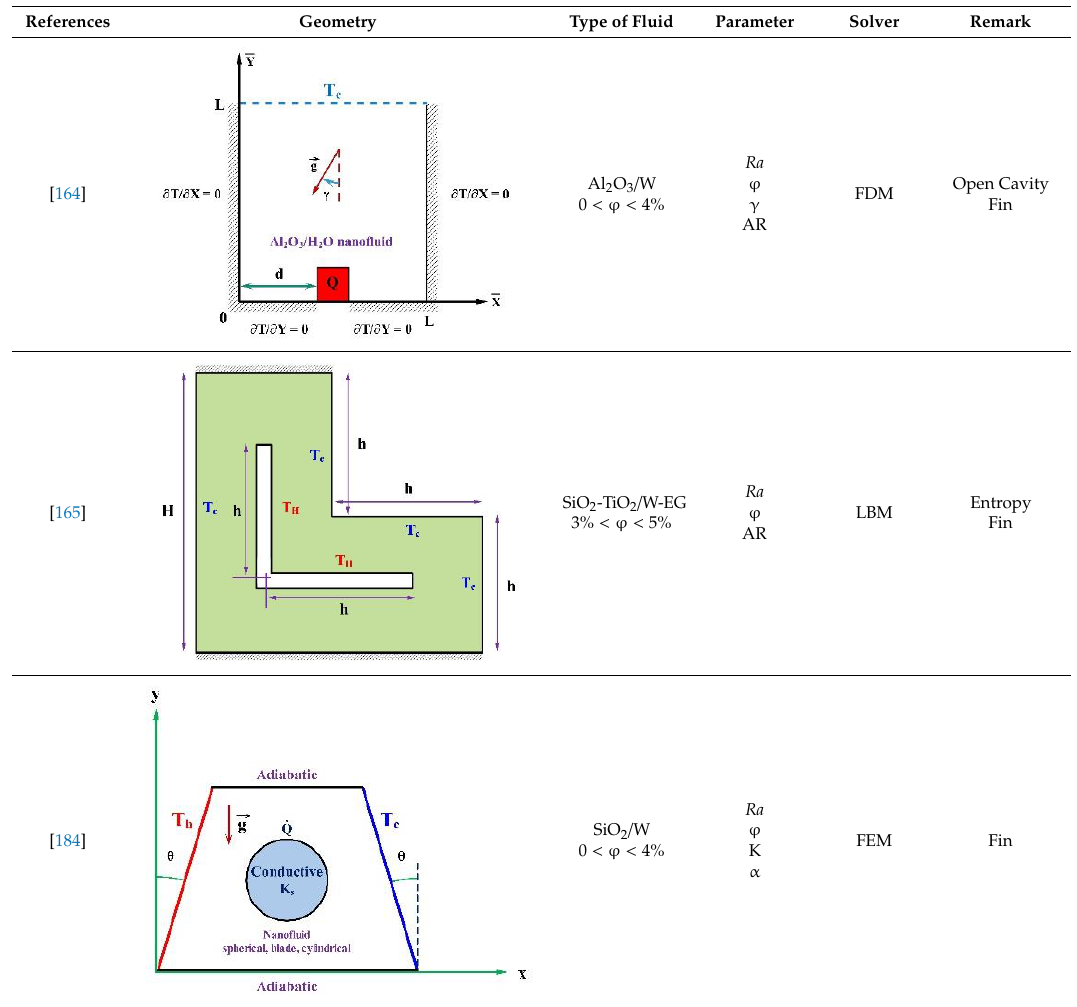
Table 9. Summary of some enclosures equipped with fins.